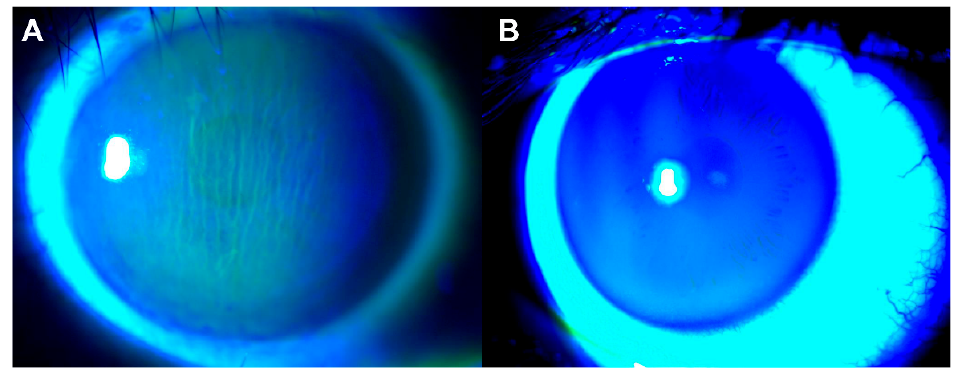
Figure 1. Corneal striae were determined during slit-lamp examination after sodium fluorescence staining. ( A ) Corneal striae in TAO. ( B ) Normal cornea in TAO.